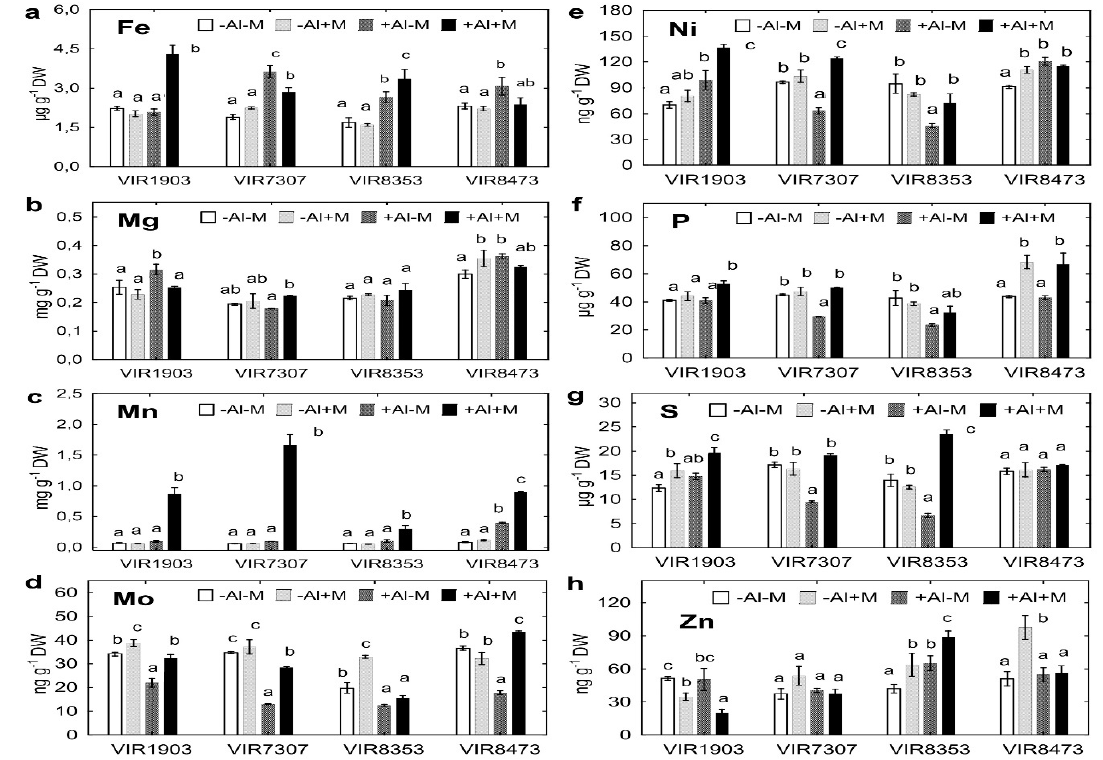
Figure 6. Concentration of nutrients Fe ( a ), Mg ( b ), Mn ( c ), Mo ( d ), Ni ( e ), P ( f ), S ( g ) and Zn ( h ) in the rhizosphere of pea genotypes VIR1903, VIR7307, VIR8353 and VIR8473 inoculated with microbial consortium. See details in the legend to Figure 1.